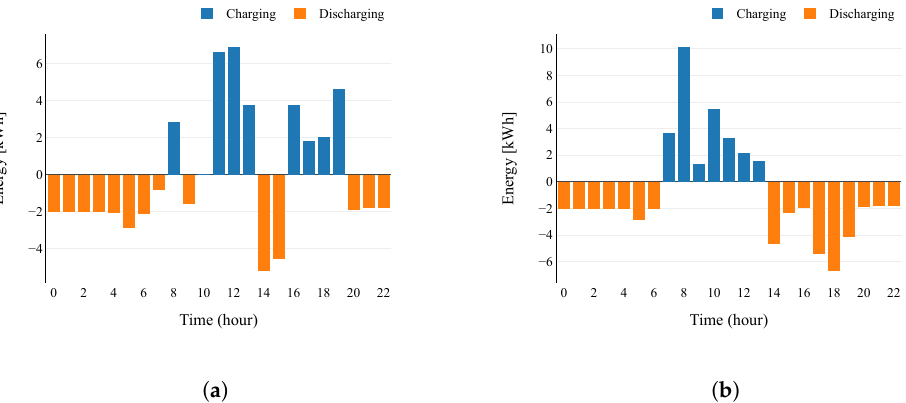
Figure 15. Average SoC of the BESS. ( a ) PV-BESS-DG configuration; ( b ) PV-BESS configuration. Figure 16 corresponds to the charging and discharging Process of the BESS in a day for PV-BESS-DG and PV-BESS configurations. At hour 8, the BESS is loaded by the PV system and the diesel generator. At hour 10, there is no charging or discharging process. This is because the diesel generator and the PV system supply the load. At hours 11, 12 and 13, the highest energy supplied by the system to charge the BESS is observed. At hours 14 and 15, it is necessary to use the BESS to feed the load because the production of the PV system is reduced. At hours 16, 17, 18 and 19, the BESS is in the process of charging, taking advantage of the energy remaining in the diesel generator after feeding the load.